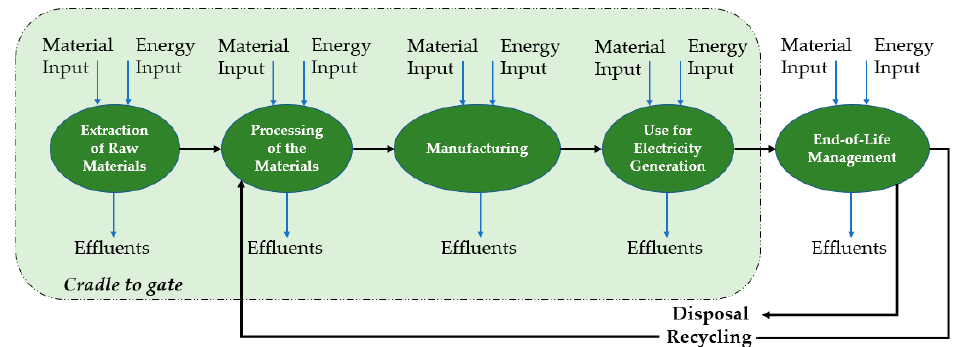
Figure 3. The lifecycle stages of the typical photovoltaic module and the system.